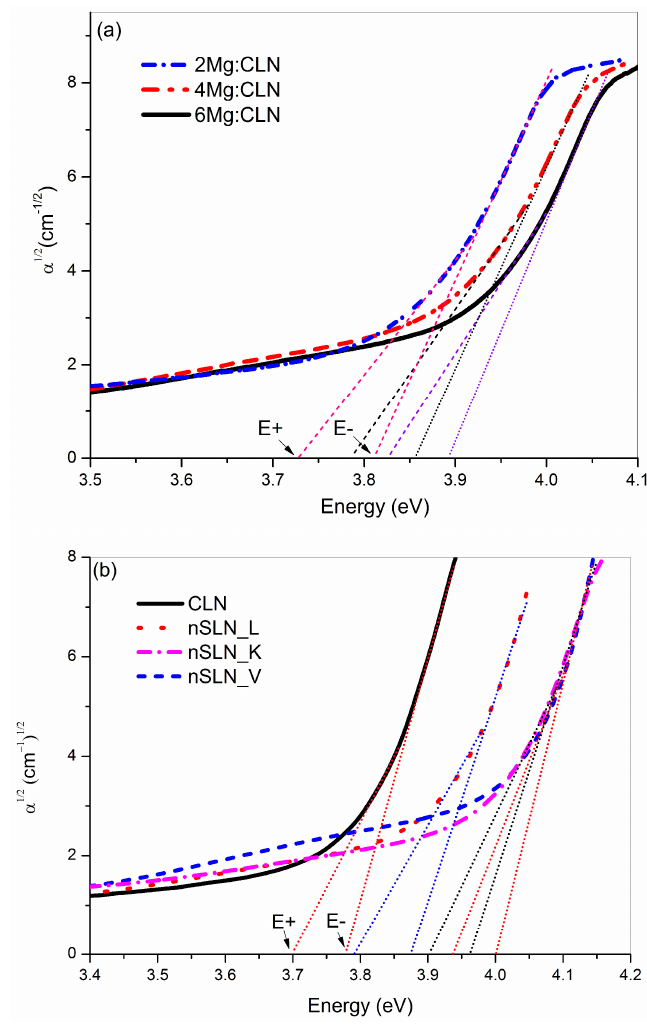
Figure 8. Dependence of α 1/2 on incident photon energy ( h ν ) for ( a ) Mg:CLN; ( b ) undoped CLN and nSLN crystals.